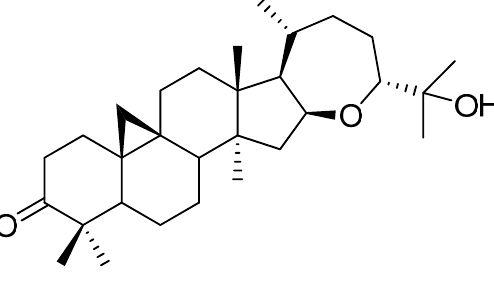
Figure 1. Chemical structure of argentatin B (16 β , 24 R -16,24-epoxi-25-hidroxicicloartan-3-one).